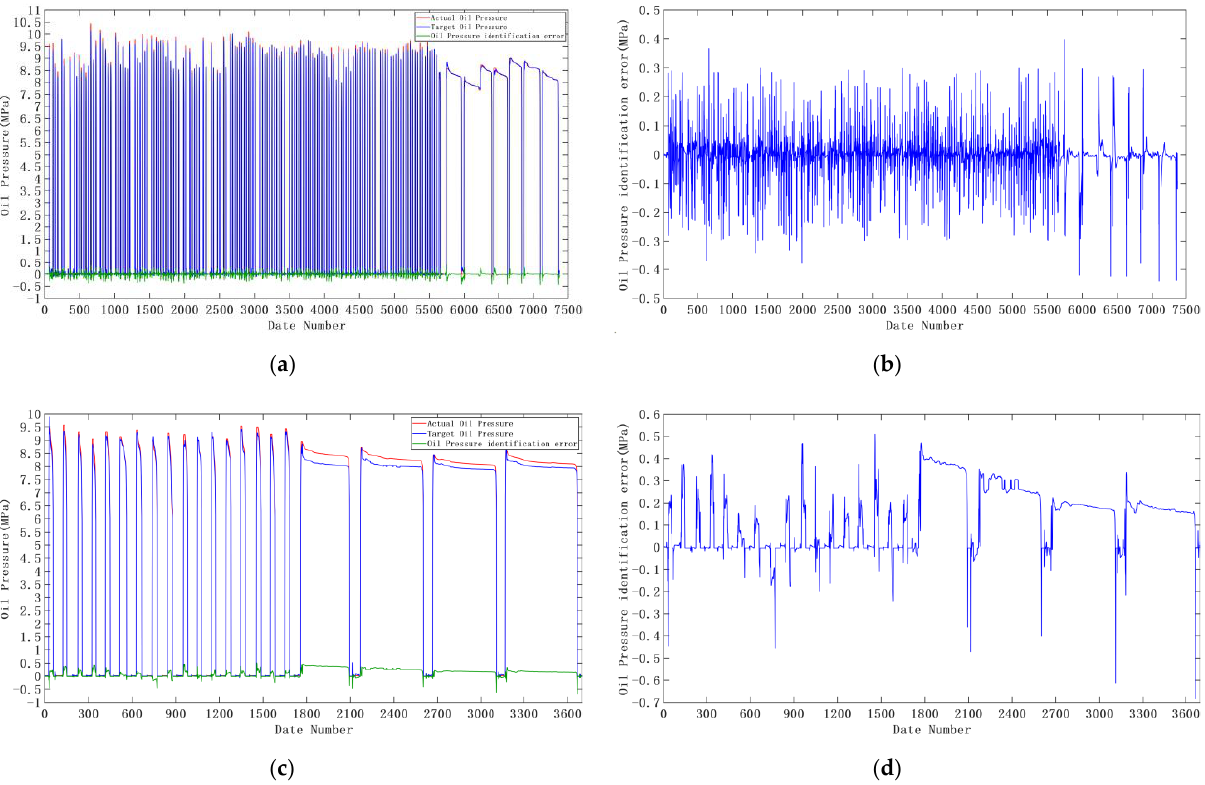
Figure 15. Oil pressure recognition results of the training set and testing set under emergency braking conditions: ( a ) Actual oil pressure, target oil pressure and oil pressure identification error of training set. ( b ) Oil pressure identification error of training set. ( c ) Actual oil pressure, target oil pressure and oil pressure identification error of testing set. ( d ) Oil pressure identification error of testing set.